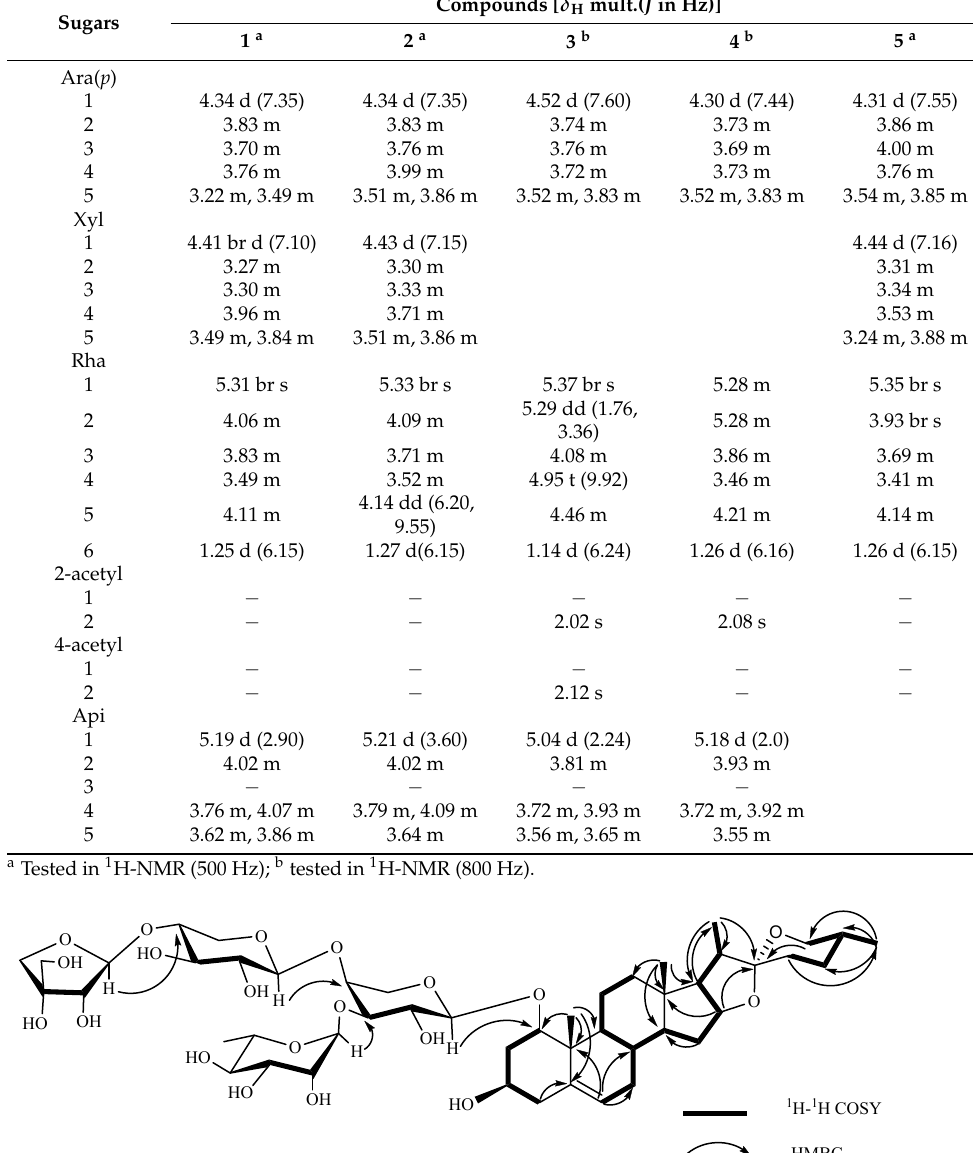
Table 4. 1 H-NMR data of the sugar portion of compounds 1 – 5 in CD 3 OD. Sugars